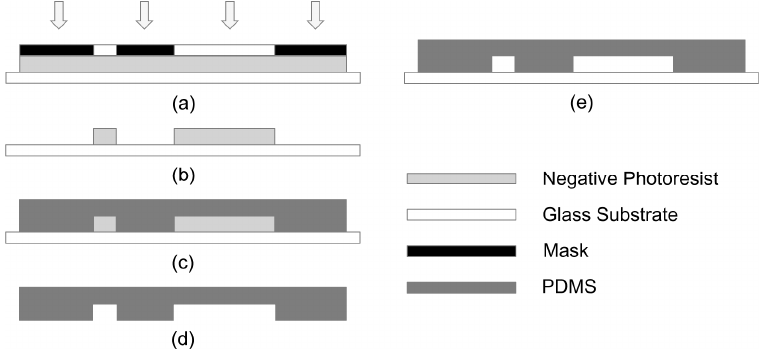
Figure 1. The scheme of the microfluidic chip fabrication: ( a ) photolithography process; ( b ) developing process; ( c ) cast process; ( d ) PDMS demolding process; ( e ) bonding